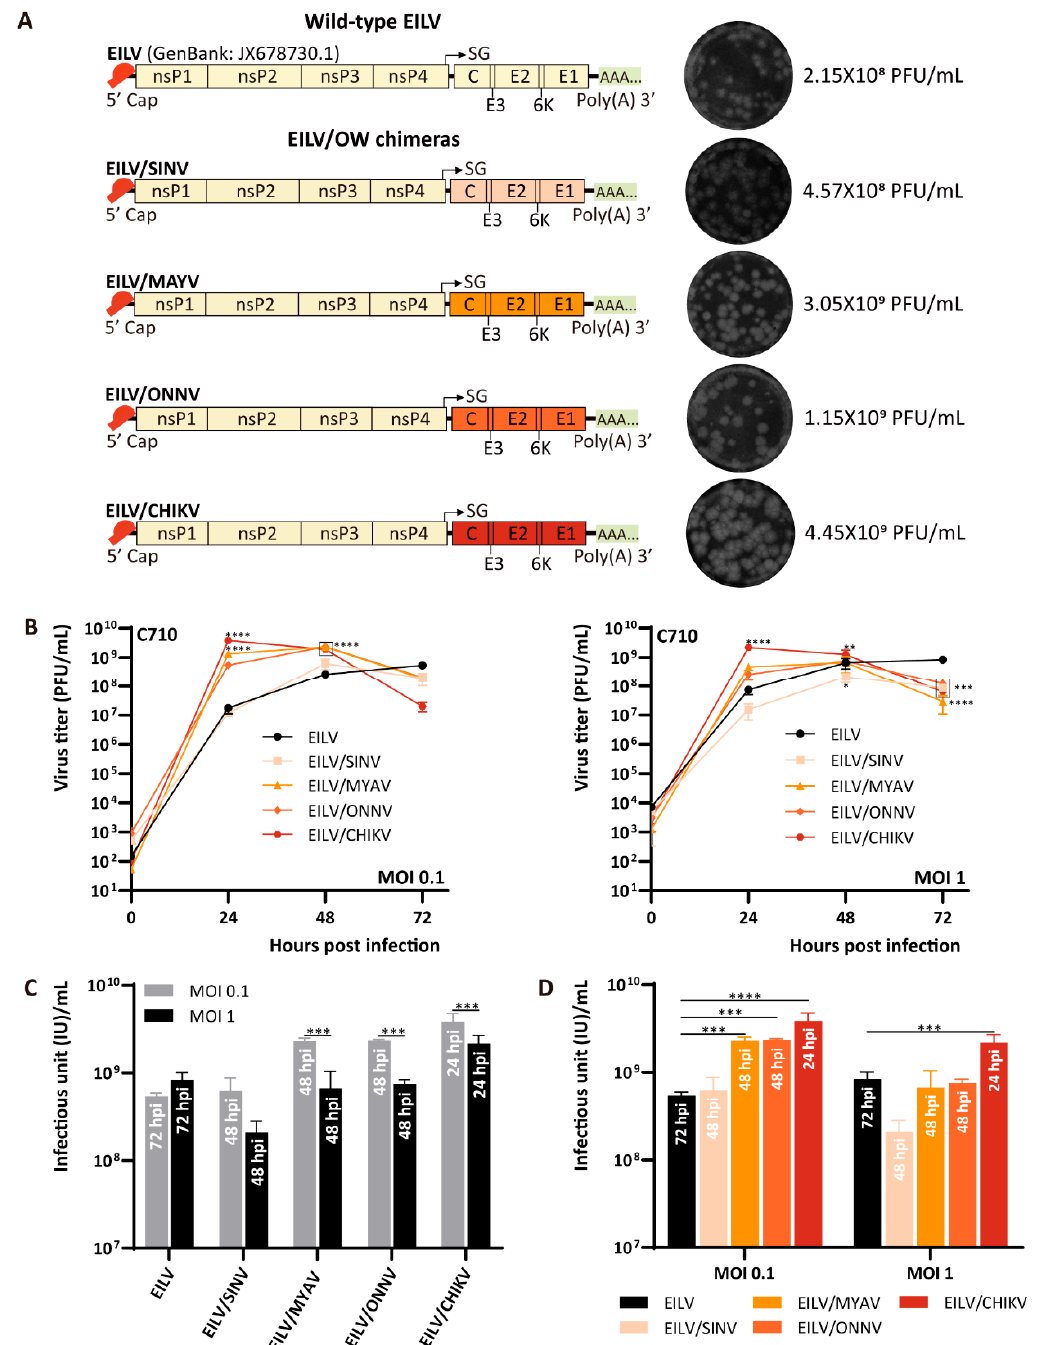
Figure 1. Genome organization and replication kinetics of Eilat virus/ Old World (EILV/OW) chimeras. ( A ) Genome organization of EILV/OW chimeras. Viruses were rescued on C7/10 cells and harvested at 2 days post-electroporation (dpe). Rescue titers and plaque phenotypes are displayed. ( B ) Replication of EILV/OW chimeras in C7/10 cells. Cells were infected at a multiplicity of infection (MOI) of 0.1 or 1. Media were collected at the indicated time points post-infection, and titers were determined by plaque assay. ( C ) The optimal titers obtained by each virus with different MOIs. ( D ) Comparison of the optimal titers produced by EILV and EILV/OW chimeras. The annotation embedded in each bar in ( C ) and ( D ) indicates the time point of reaching the highest titer. Each sample was titrated twice ( n = 2). Average titers ± standard deviations (SD) (error bars) are shown. *, p < 0.05; **, p < 0.01; ***, p < 0.001; ****, p < 0.0001.